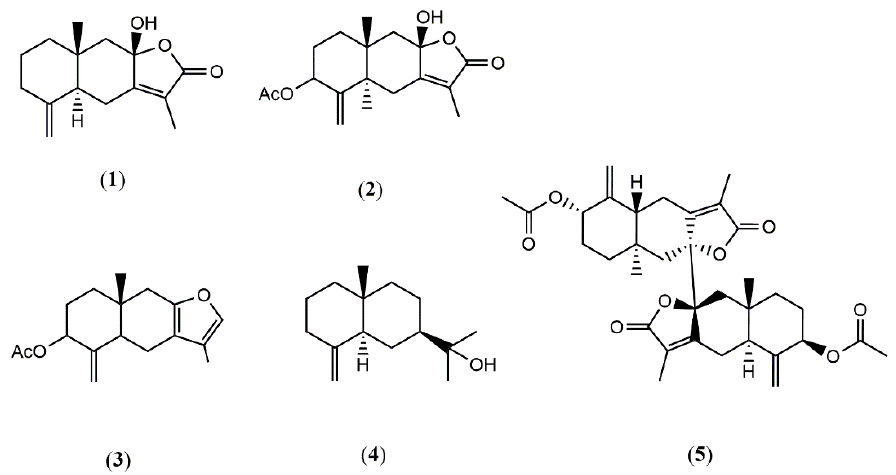
Figure 1. The chemical structure of compounds 1–5 from the wild A. macrocephala . Atractylenolide III ( 1 ). C 15 H 20 O 3 . White needle crystal (Petroleum ether -AcOEt), mp 183–185 °C. ESI-MS: m/z 249 [M + H] + . 1 H and 13 C NMR data and MS data were consistent